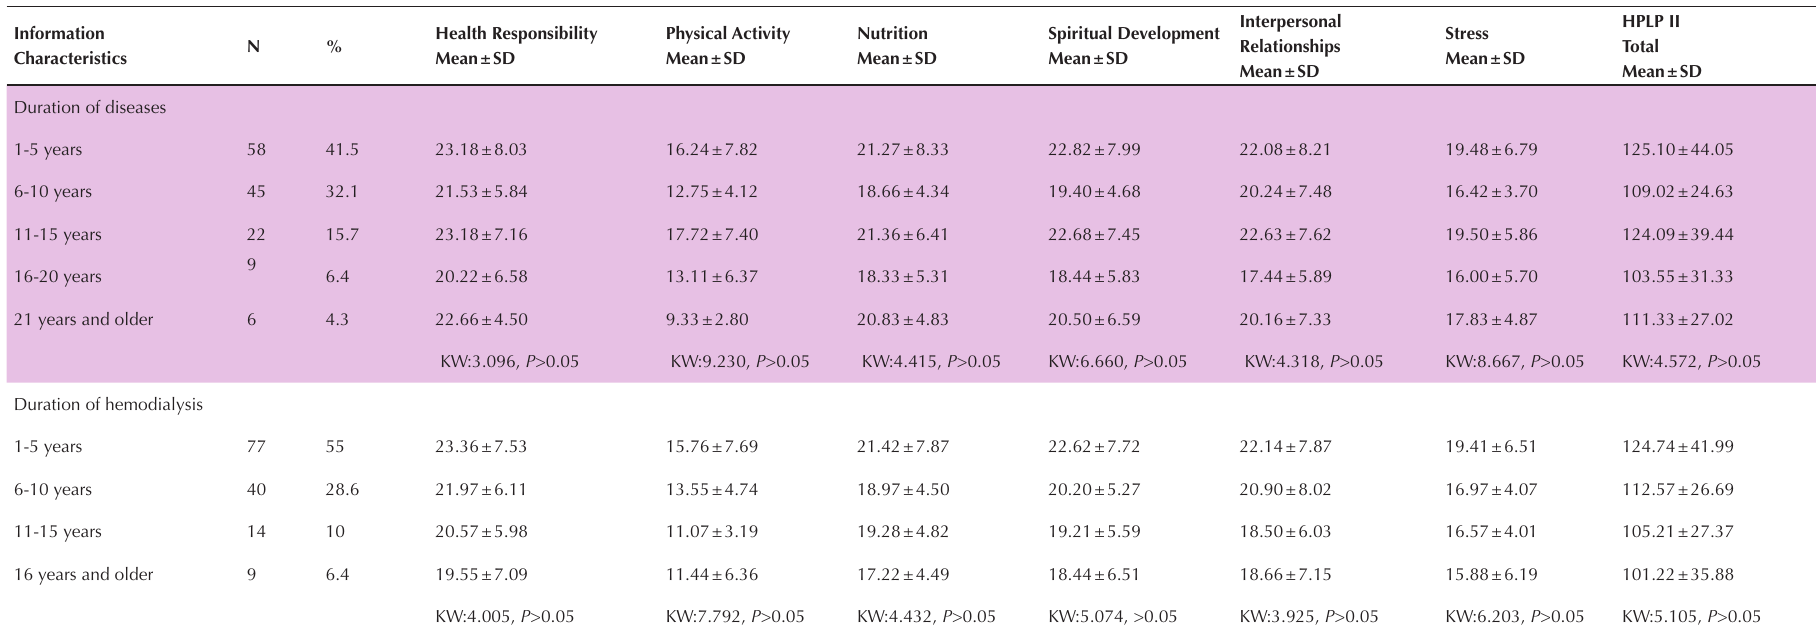
Interpersonal Relationships